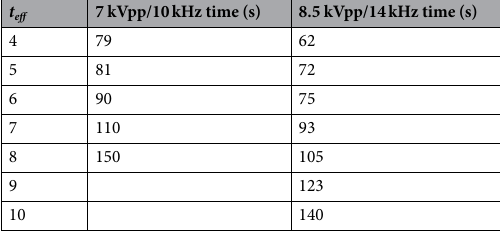
t eff 7 kVpp/10 kHz time (s) 8.5 kVpp/14 kHz time (s)